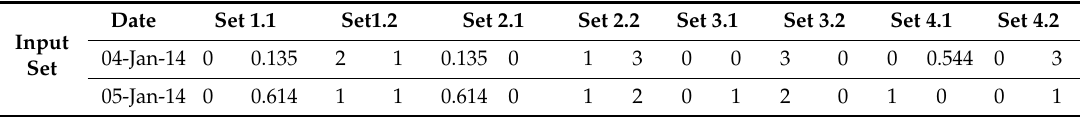
Table 6. 04-Jan-14 Input Set.